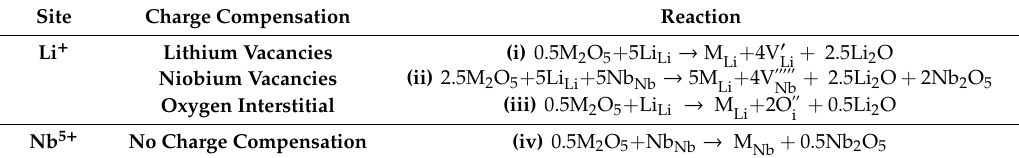
Table 9. Types of defects considered due to Mo 5 + incorporation in LiNbO 3